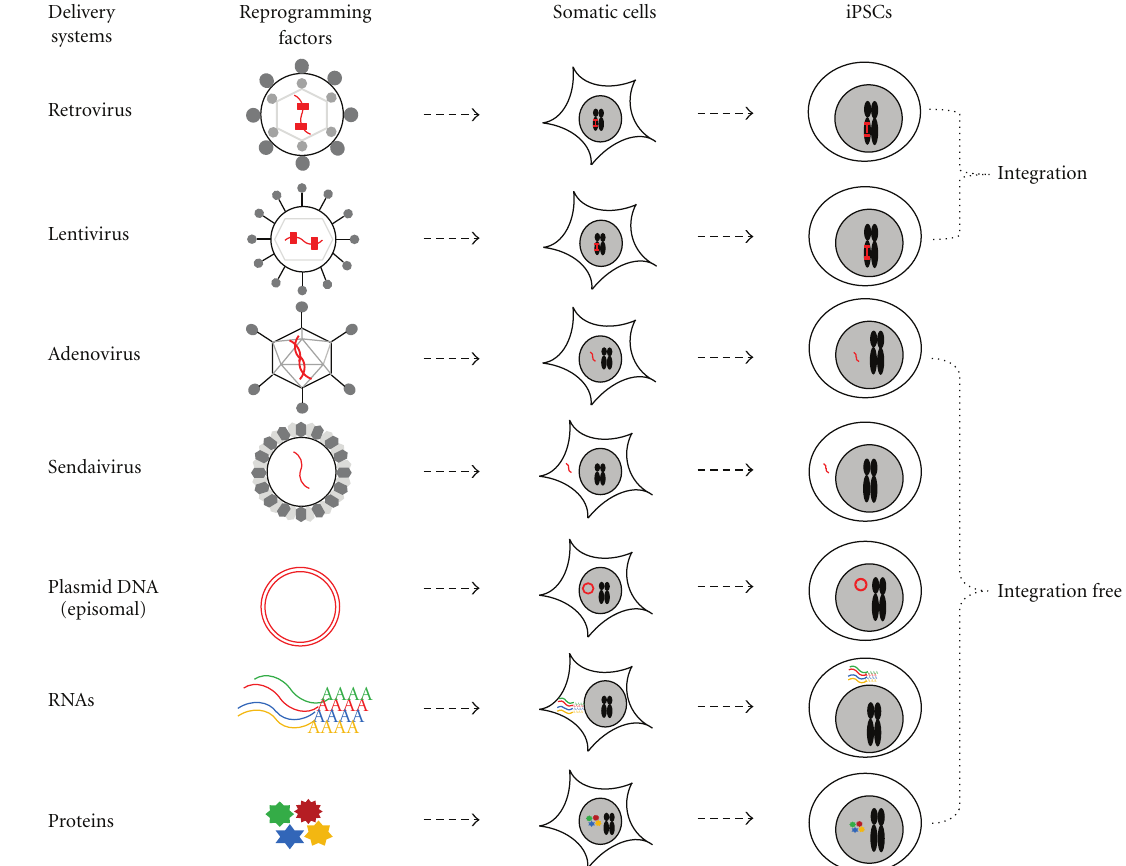
Figure 1: strategies for generation of somatic cells into induced pluripotent stem cells (iPSCs) using di ff erent gene delivery